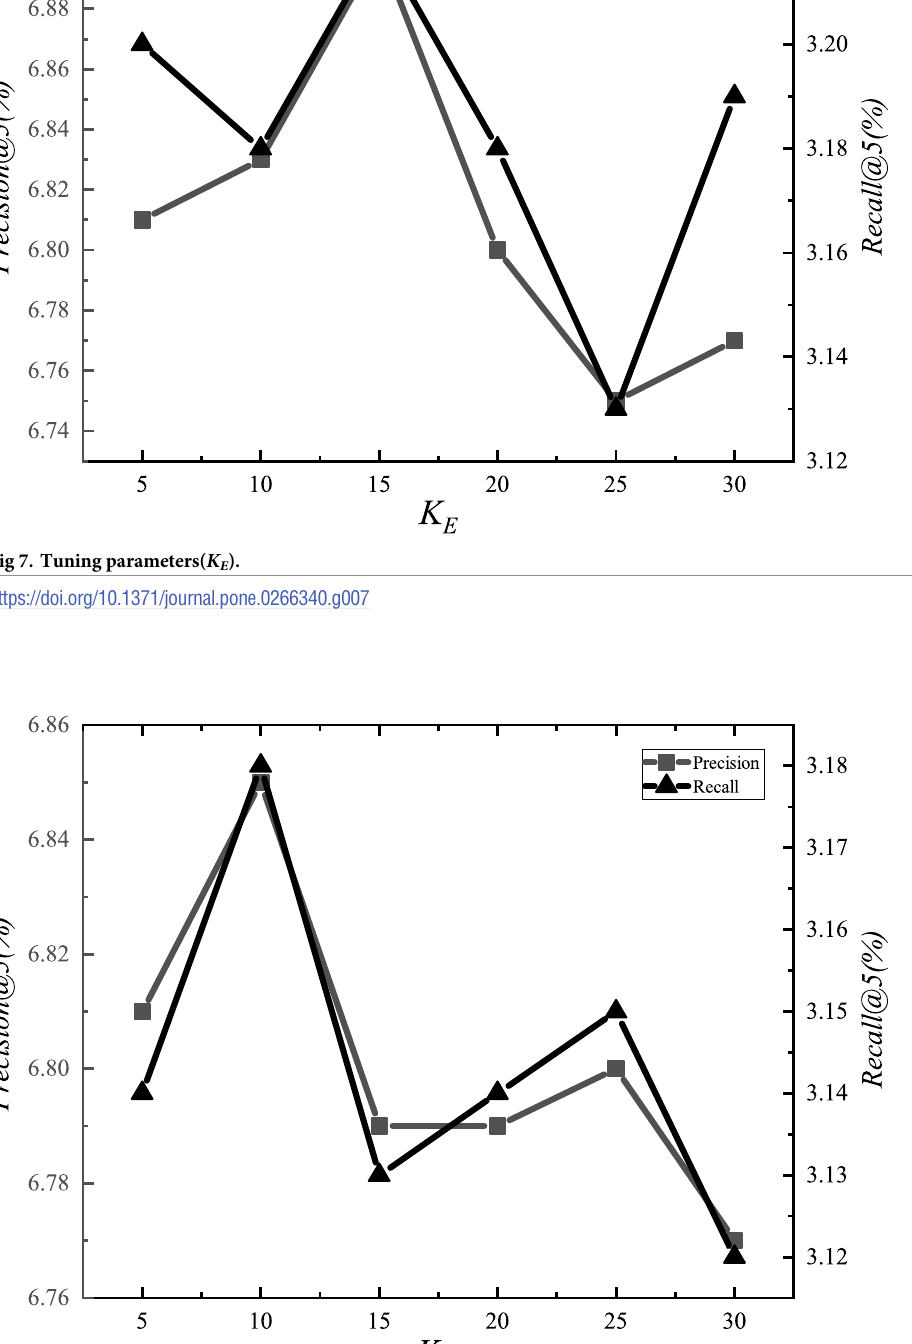
Fig 8. Tuning parameters( K G